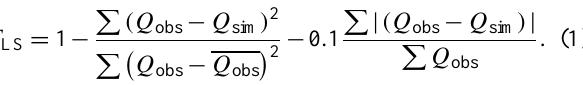
precipitation and air temperature as well as estimates of long- term monthly potential